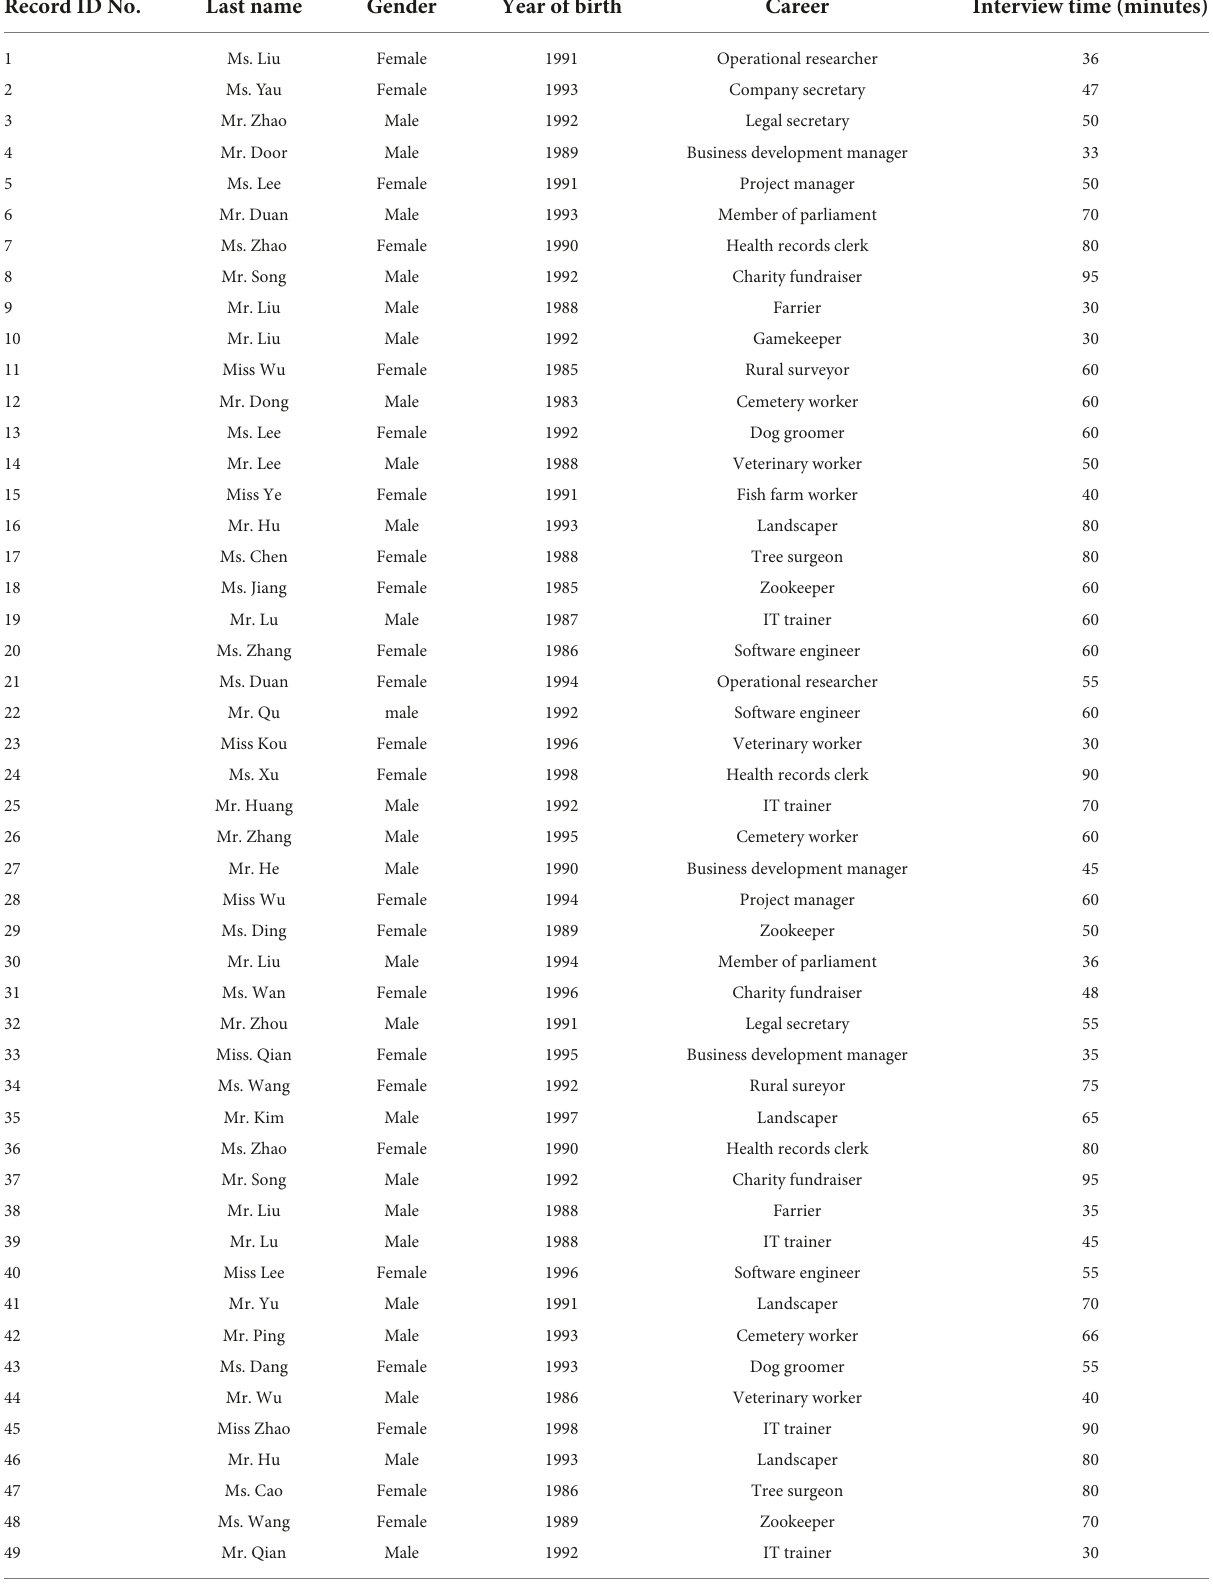
TABLE 1 Basic information of